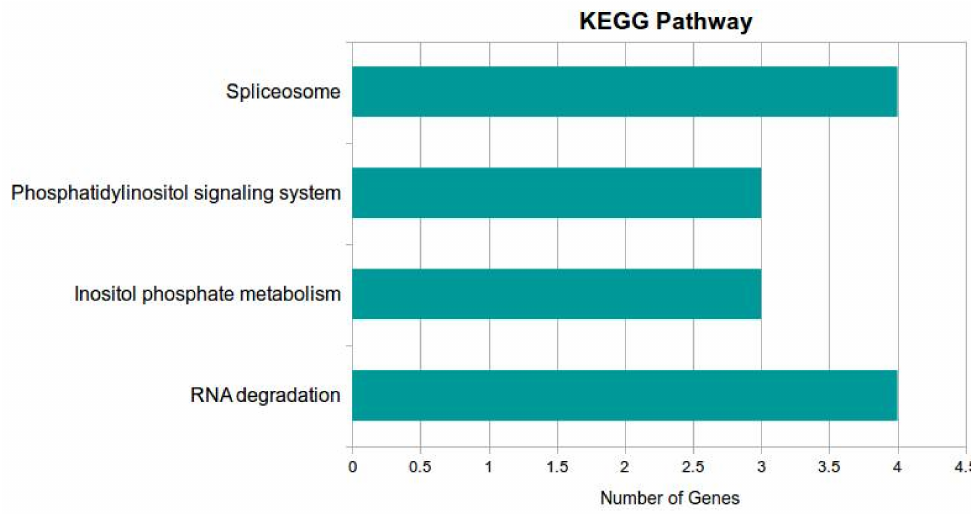
Figure 6. miRNAs involved in various pathways, namely, spliceosome, phosphatidyl inositol signaling system, inositol phosphate metabolism, and RNA degradation.